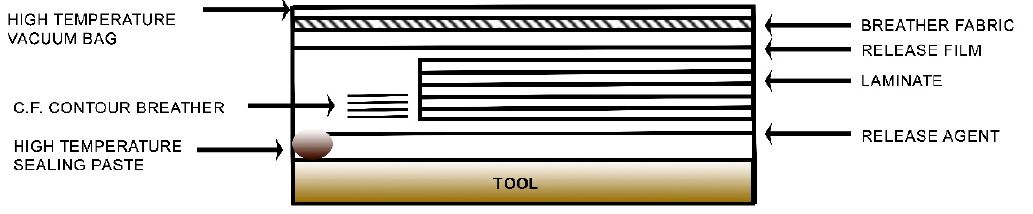
Figure 3. Scheme of the prepared vacuum bag.